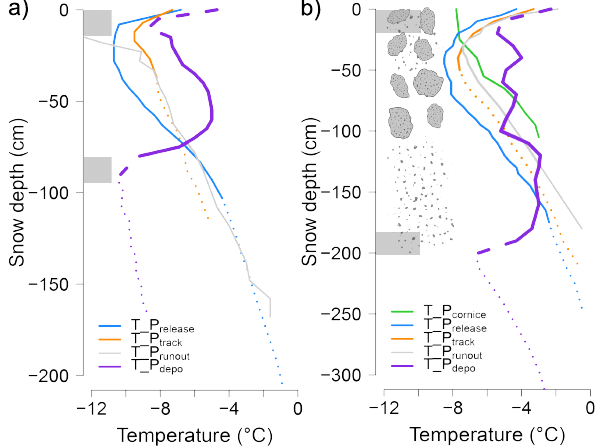
Figure 9. Snow temperature measurements conducted in the undis- turbed snow cover close to the release zone ( T _ P release ), along the path ( T _ P track ) and in the run out zone ( T _ P runout ) as well as in the deposition zone ( T _ P depo ) of (a) avalanche #2 and (b) avalanche #3. Release, entrainment and deposition depths are indicated by solid lines, whereas the undisturbed snow cover is rep- resented by pointed lines. Gray areas and dashed lines indicate parts of the temperature profiles in the deposits ( T _ P depo ) that were ne- glected in the calculations because of expected changes in temper- ature over time due to the boundary conditions of the surface and the undisturbed snow cover. Composition of deposits (granules and fine grains) are indicated for avalanche